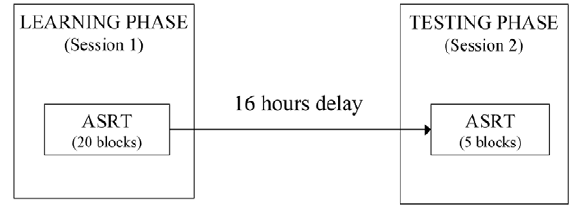
Figure 1. Experiment design. There were two sessions in the experiment: a Learning Phase (Session 1) followed by a Testing Phase (Session 2) after a 16-hour delay.